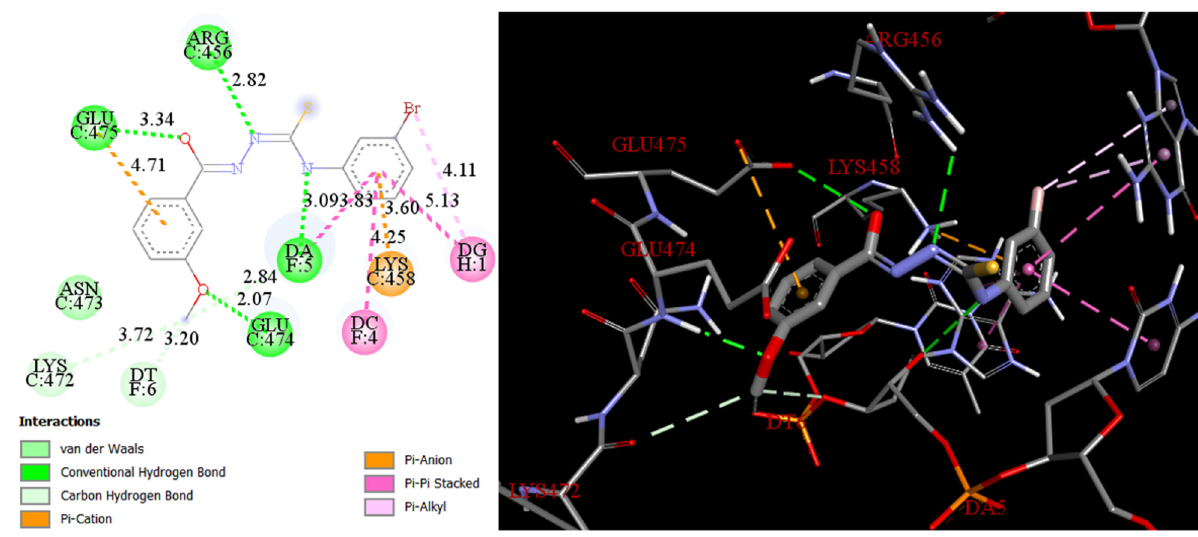
Figure 2. 2D & 3D interaction maps of SA15 with topoisomerase IV (PDB 3LTN).